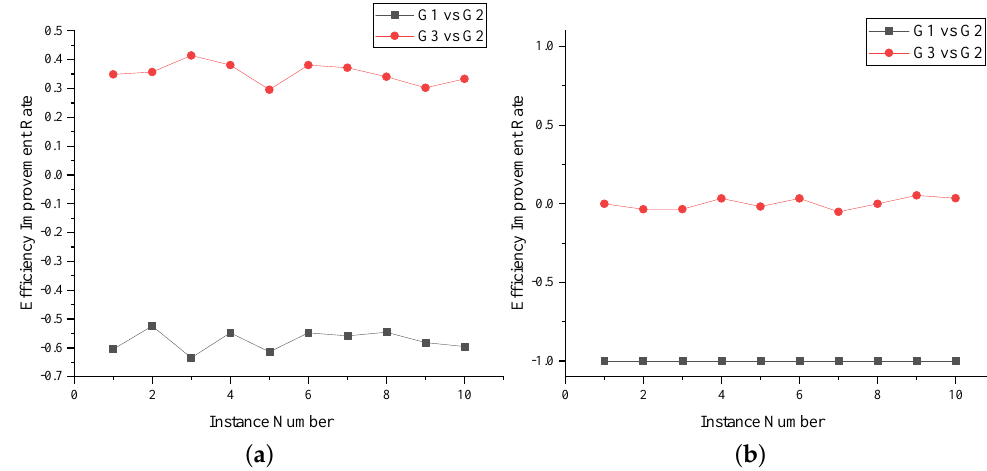
Figure 4. Comparative experimental results obtained with different state selection crite- ria. ( a ) LightFTP. ( b )